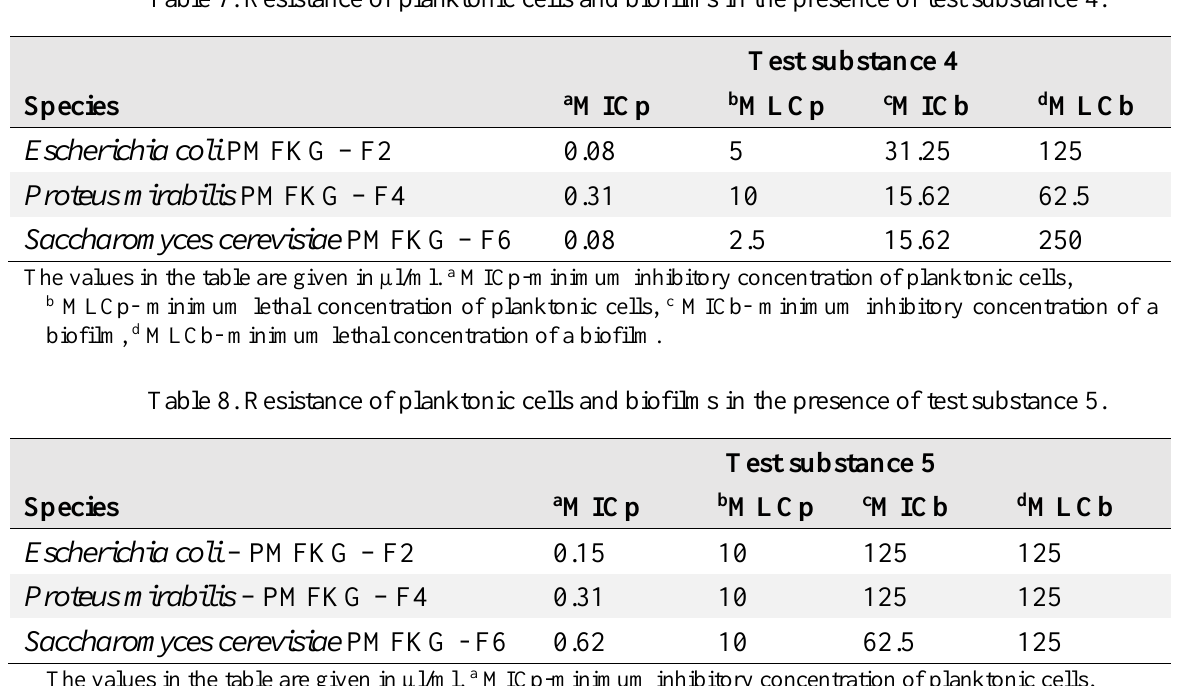
Table 7. Resistance of planktonic cells and biofilms in the presence of test substance 4.